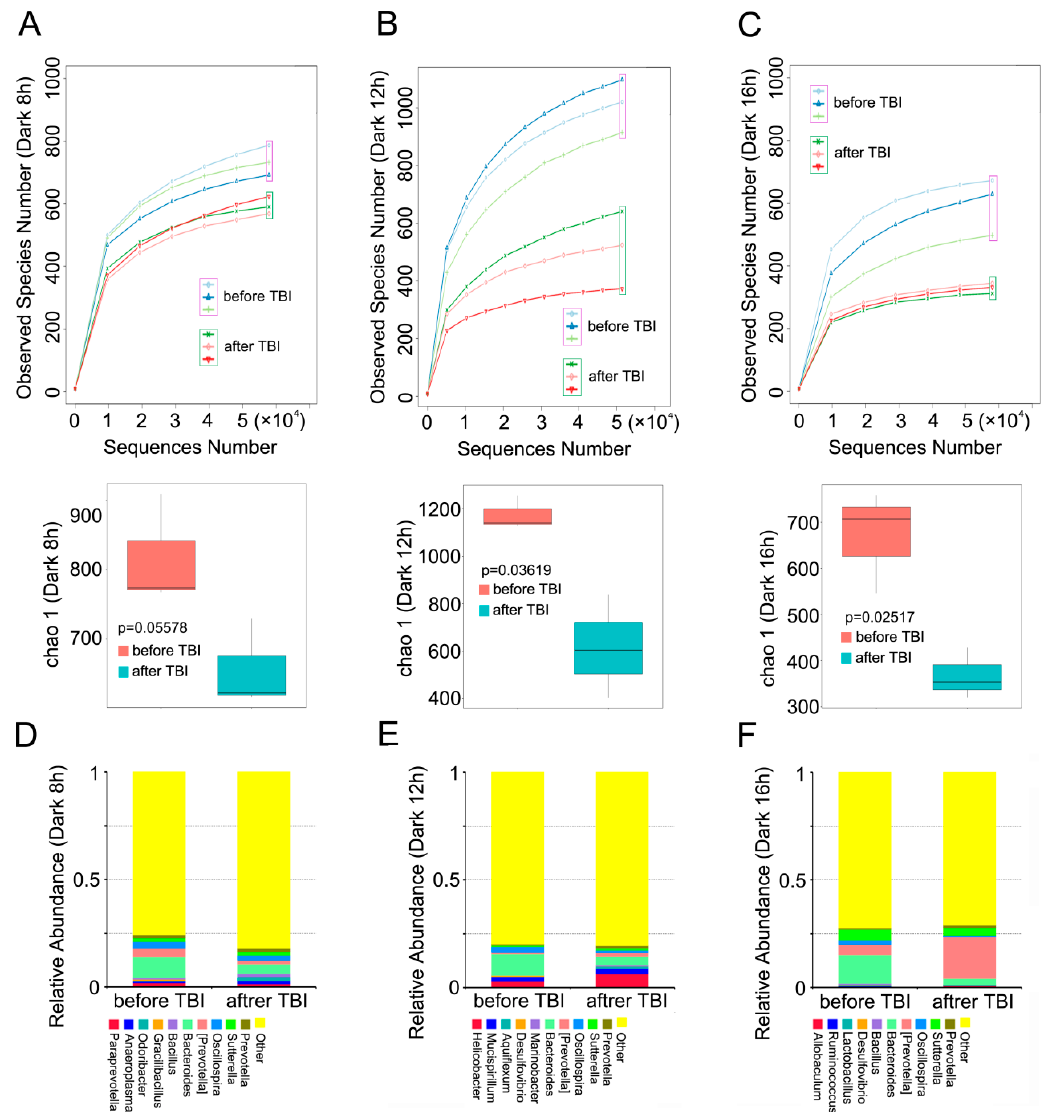
Figure 4. Circadian rhythm governs the response of gut bacterial composition shift to irradiation. ( A – C ) The number of observed species of enteric bacteria in mice housed in 8 h dark/16 h light ( A ), 12 h dark/12 h light ( B ), and 16 h dark/8 h light ( C ) cycles was assessed using 16S RNA sequencing, n = 3 per group; ( D – F ) The relative abundance of the top 10 bacteria at the phylum level in mice housed in 8 h dark/16 h light ( D ), 12 h dark/12 h light ( E ), and 16 h dark/8 h light ( F ) cycles was measured using 16S RNA sequencing, n = 3 per group. Statistically significant differences are indicated: Wilcoxon rank sum test.